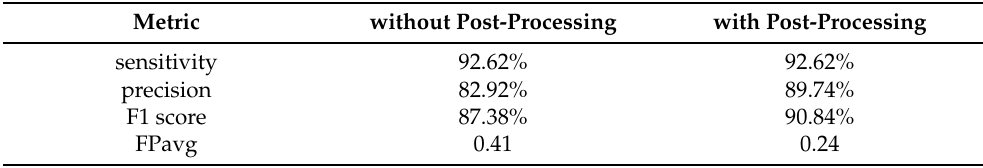
Table 6. Results with post-processing compared to one without